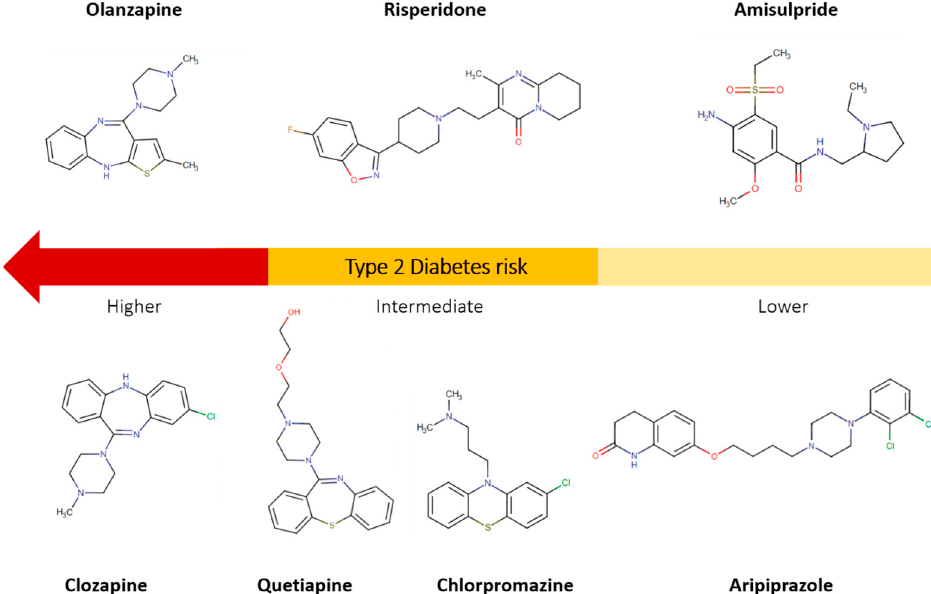
Figure 1. Scheme of antipsychotic drugs (APDS) commonly associated with diabetogenic properties. First-generation antipsychotic (FGA) = chlorpromazine; Second-generation antipsychotics (SGAs) = olanzapine, clozapine, quetiapine, risperidone, amisulpride and aripiprazole. 1.3. Elucidation of SGAs Effects on Glucose Tolerance, Insulin Resistance and Body Weight Gain: Acute